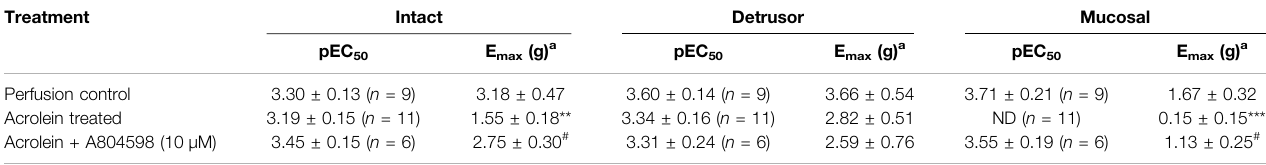
Data represent the mean ± SEM. a E max values are the contractile responses produced by ACh at the highest concentration used (10 – 2